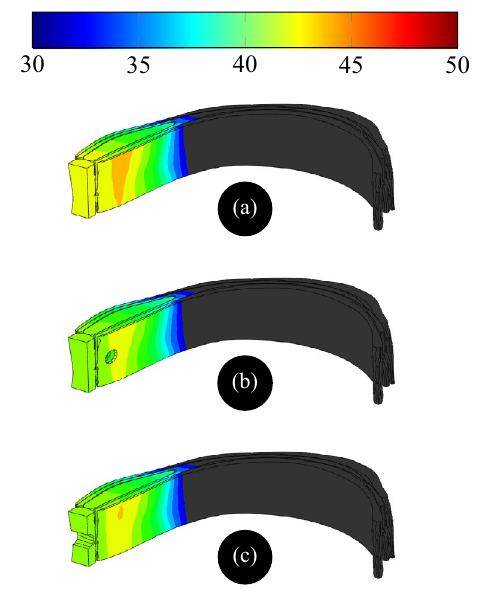
Figure 4. Magnitude of displacement in the AW subdomain ( a ) without hernia, ( b ) with incisional hernia, and ( c ) with umbilical hernia.